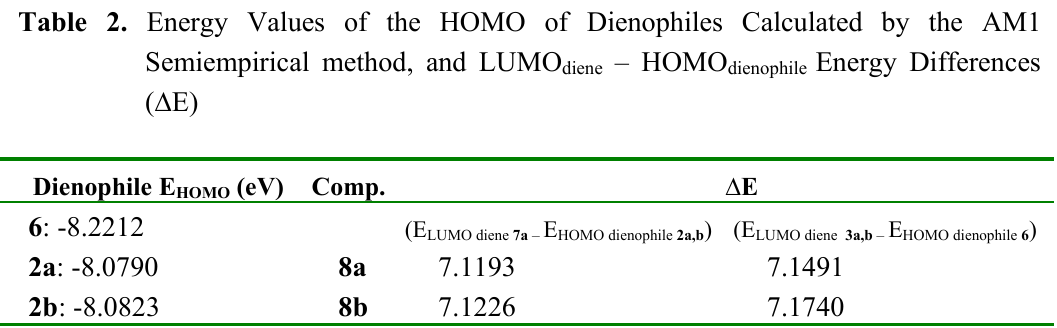
Table 2. Energy Values of the HOMO of Dienophiles Calculated by the